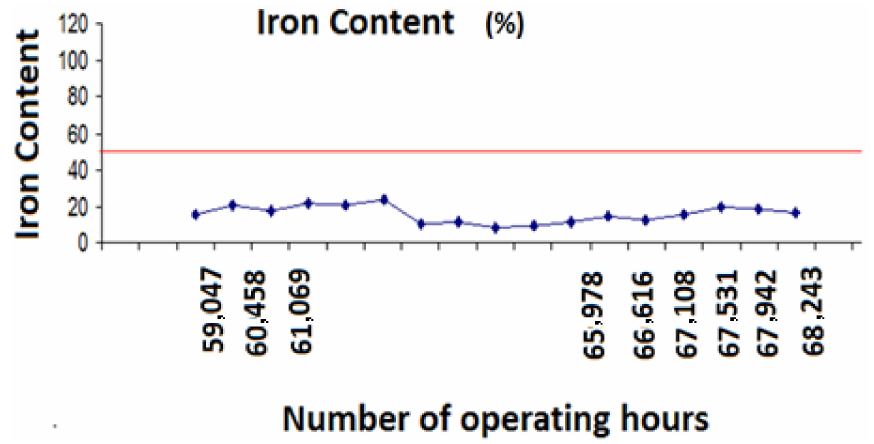
Figure 8. Iron content in lubricating oil